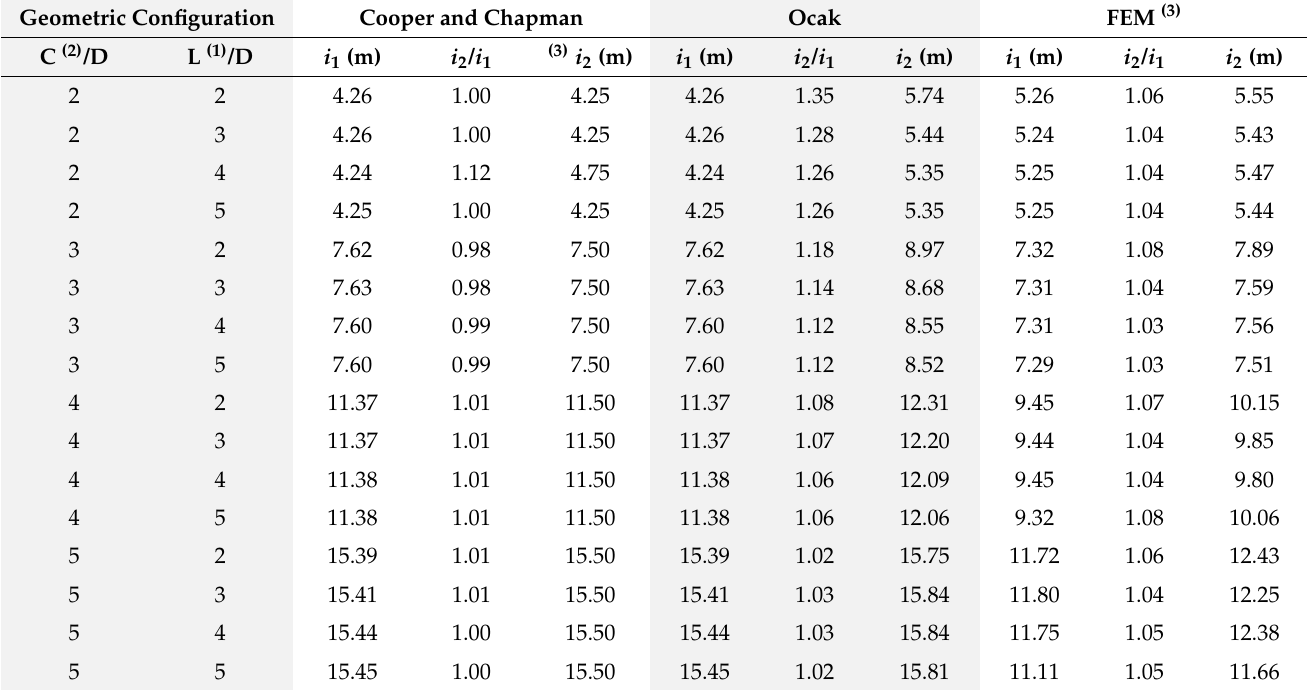
Figure 10. Eccentricity (e Smax ) for different methodologies. The eccentricity shows an inverse relation with the ratio L/C, increasing with the in- crease in such ratio and seeming to converge to 3 as L/C → ∞ ; nevertheless, for smaller ratios, Ocak’s methodology presents an eccentricity towards the 1st cavity while O’Reilly and New behave as the FEM data with eccentricity towards the second cavity. To evaluate the settlement trough width, it was necessary to apply the concept of the second derivative also to Cooper and Chapman’s [16] methodology as done for the FEM curve and compare the ratio i 2 /i 1 with the multiplying factor defined by Ocak [17], Table 6 presents the values that define the trough width and Figure 11 their variation with the ratio C/D. Table 6. Numerical analyses settlement trough width parameter “ i ” .